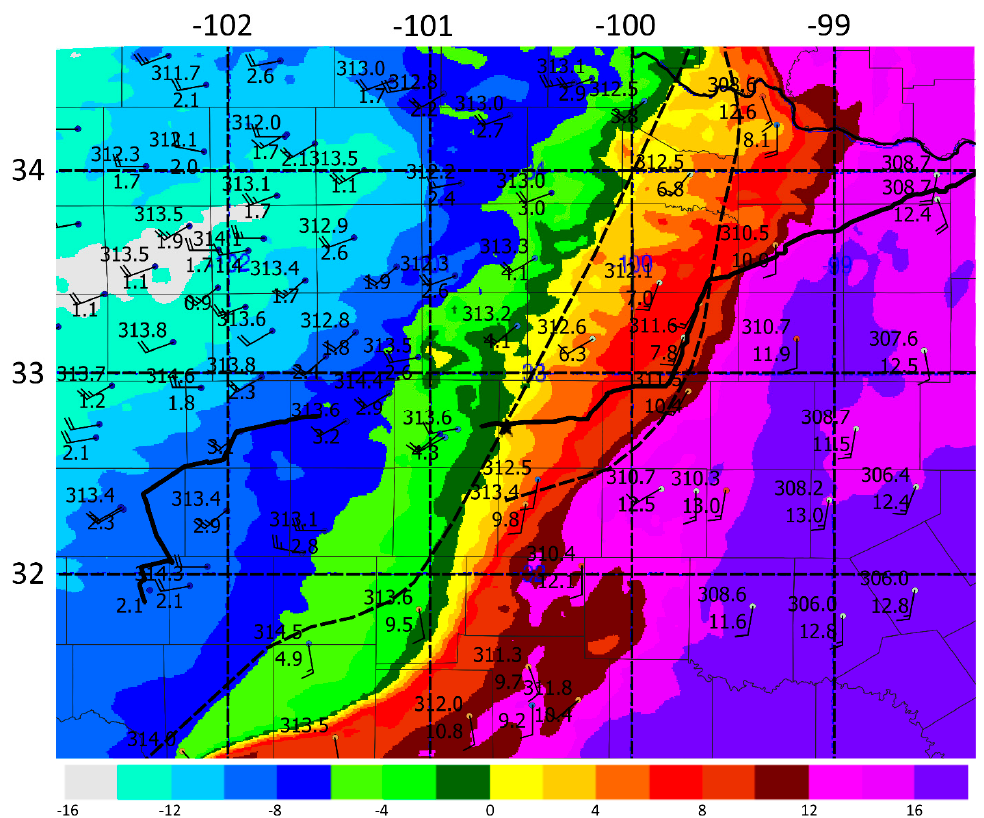
Figure 13. Analyzed dryline positions with surface observations ( θ v and mixing ratio) and HRRR dew point (C) at 2200 UTC on 9 April 2017.